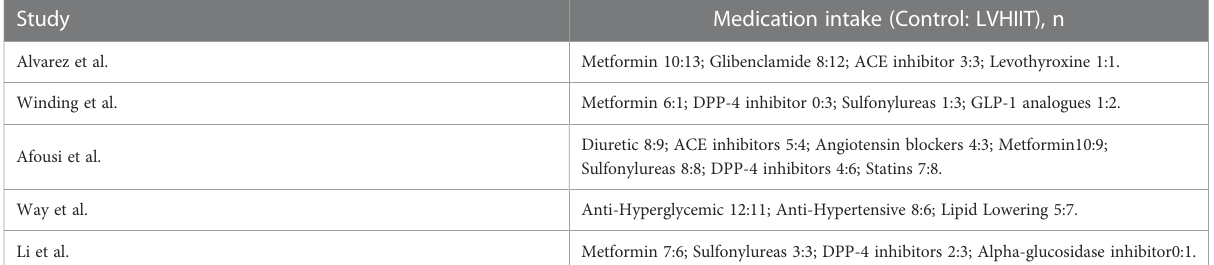
TABLE 2 Medication intake of patients. Study